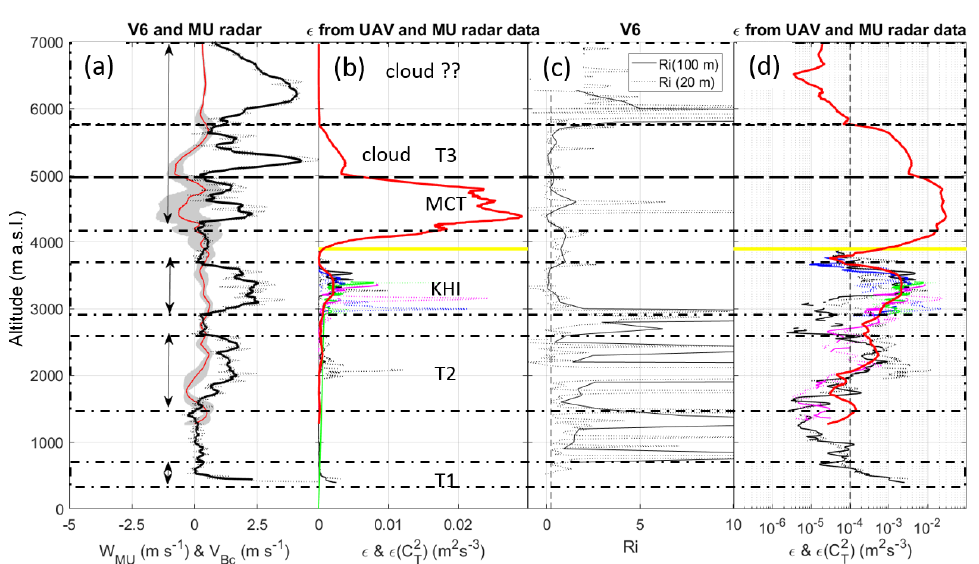
Figure 7. Same as Fig. 5 for